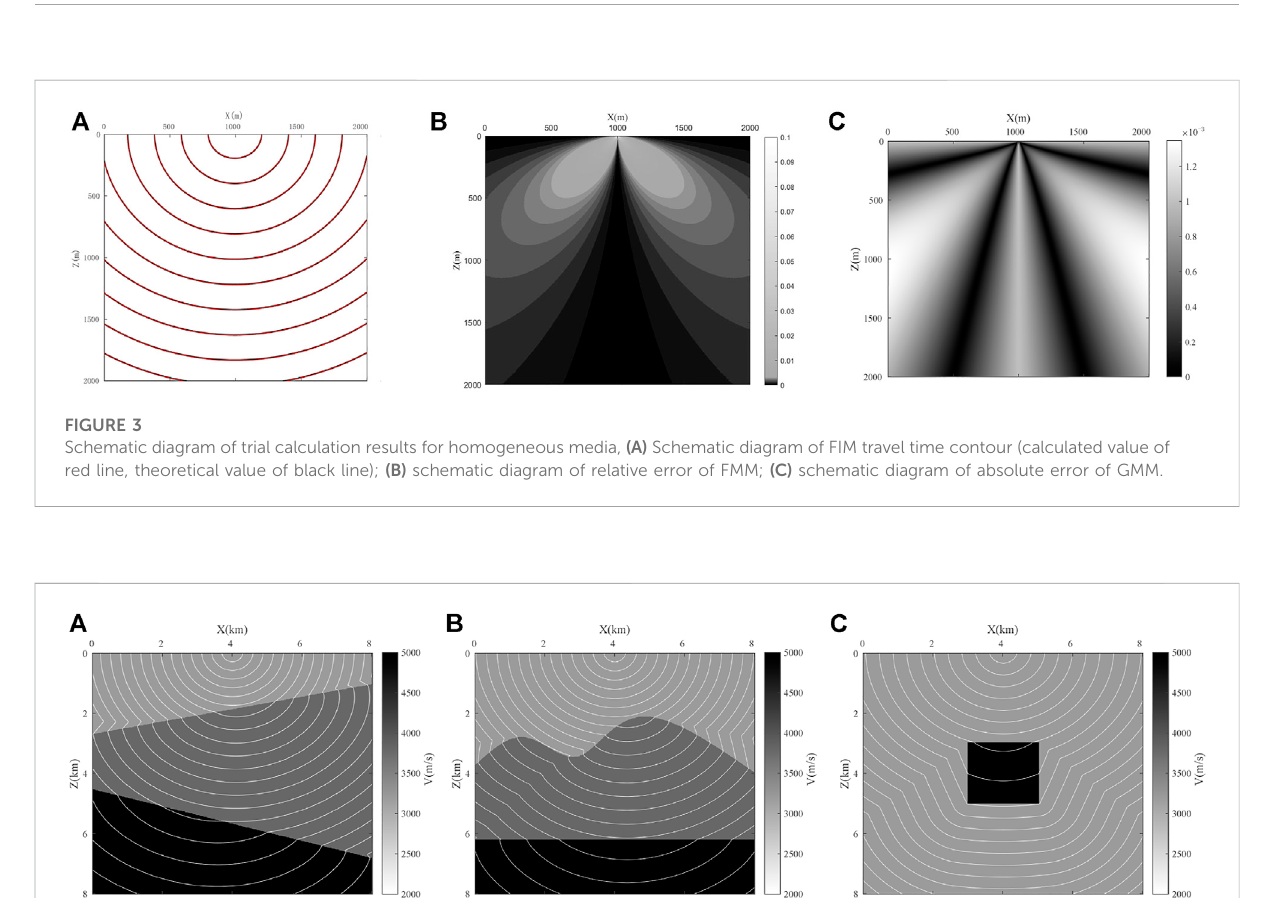
FMM and GMM have similar algorithmic structures, both of which are extended in front of the wave through Dijstra algorithm ideas. The biggest difference between the two is narrowband expansion, FMM through the priority queue to achieve the narrowband mesh point removal and insertion operation, the use of heap sorting method for narrowband minimum time point selection, so the FMM time complexity is O(Nlog 2 N) (N is the total number of calculated grid points). The GMM algorithm performs time-out calculations by